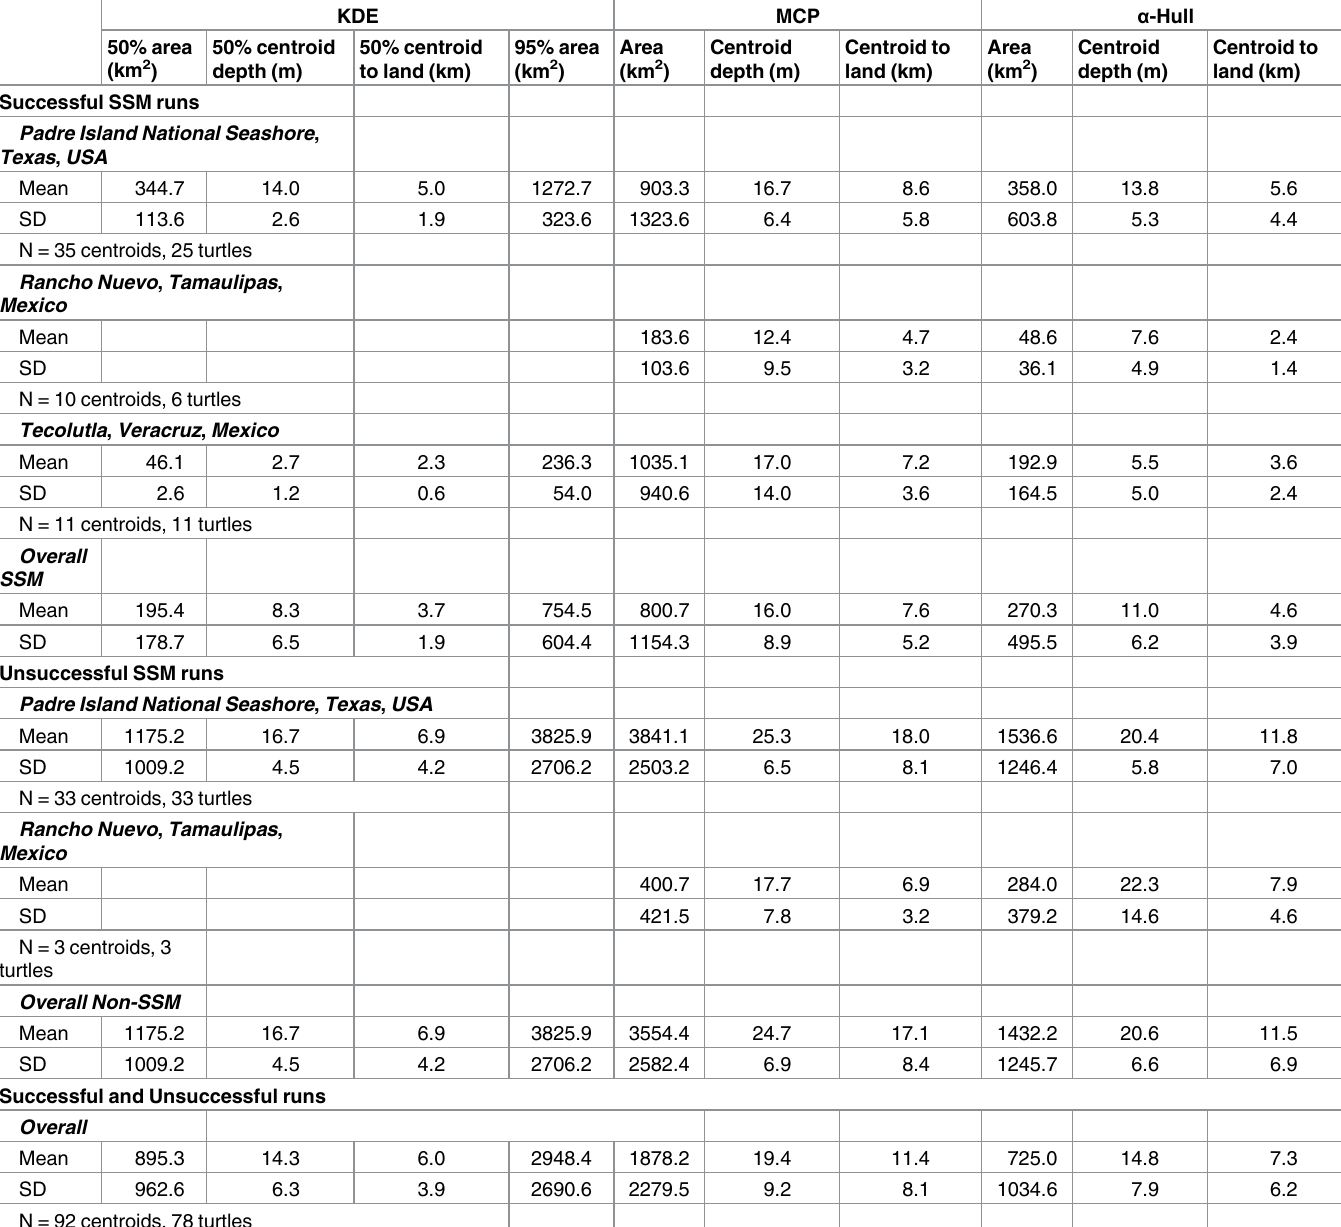
Table 1. Mean and standard deviation of Kernel Density Estimation (KDE), Minimum Convex Polygon (MCP), and α -Hull results for nesting Kemp’s ridley turtles ( Lepidochelys kempii ) with successful and unsuccessful State-Space Model (SSM) runs. KDE